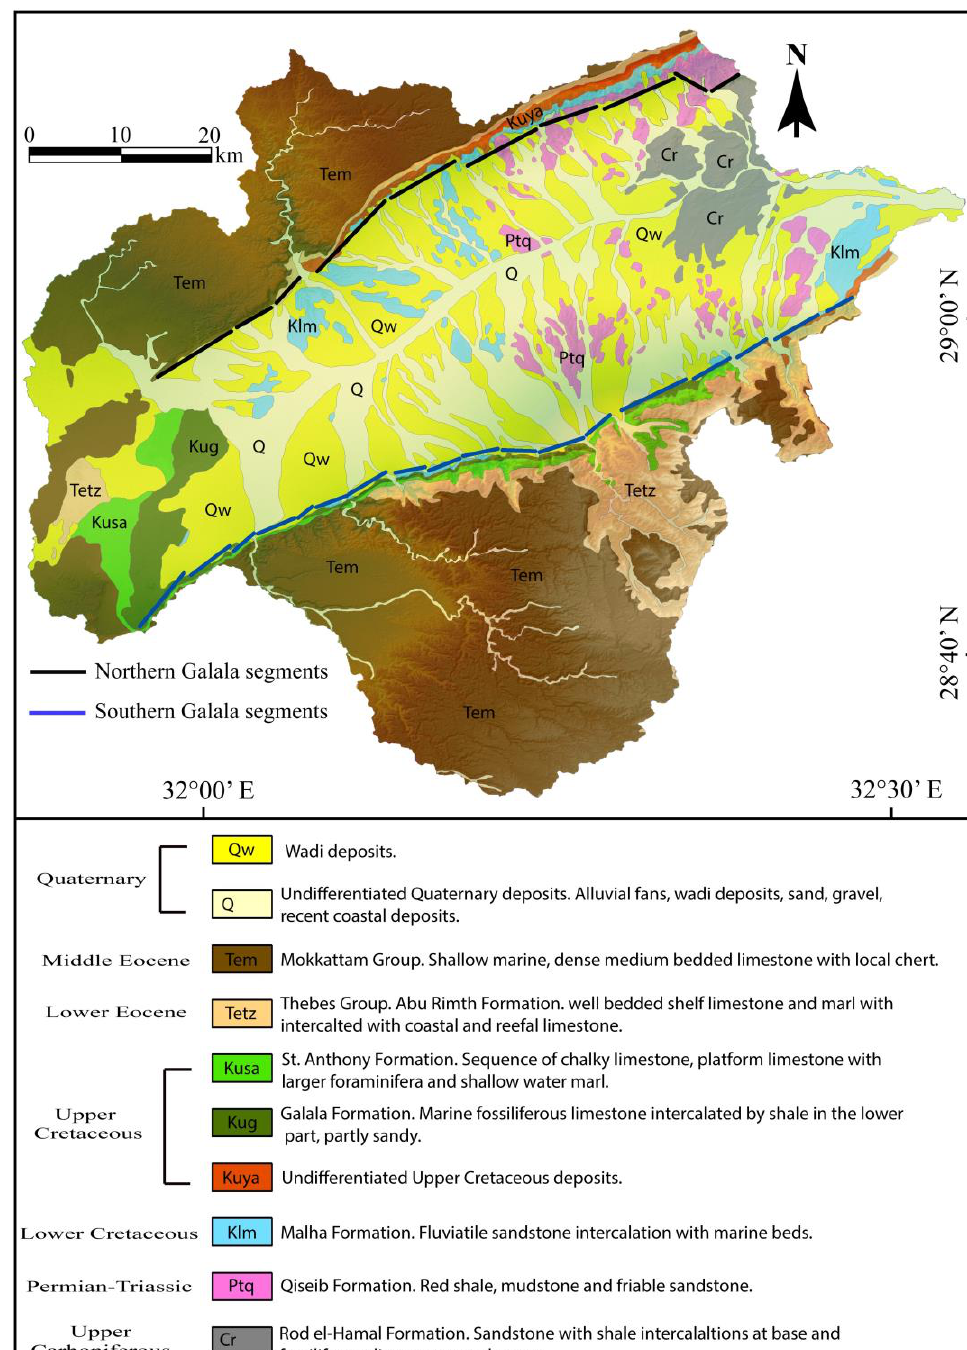
Figure 2. Detailed geological map of the study basin, modified from [28]. The Wadi Araba deformation basin is a major Late Cretaceous inversion anticline form [29]. It comprises two major ENE anticlines. This plunging anticline has a steep southern limb, where a nearly vertical Upper Cretaceous section is exposed in the